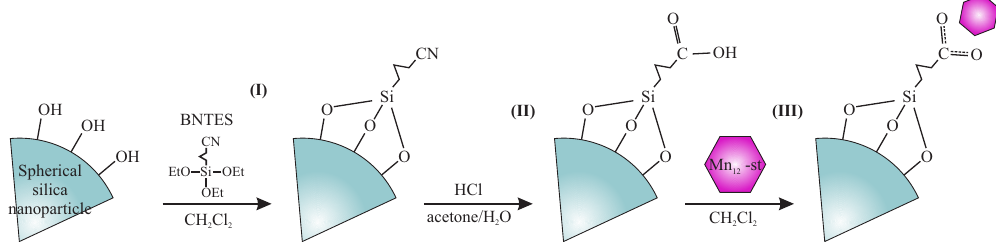
Figure 2. A schematic presentation of the synthesis procedure allowing for the separation of the Mn 12 single-molecule onto spherical silica nanoparticles. Assumed steps: grafting (I), hydrolysis (II), and functionalization (III).